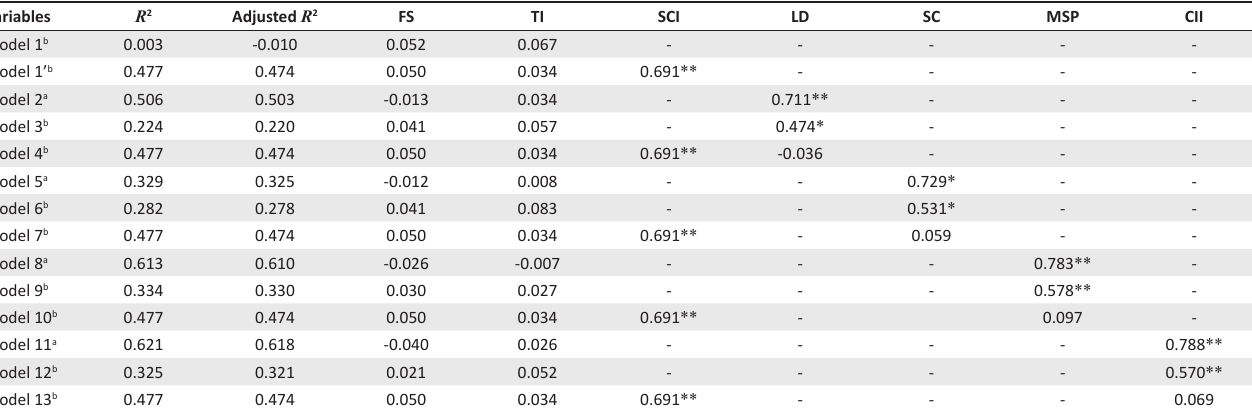
TABLE 3: Regression results for financial performance.